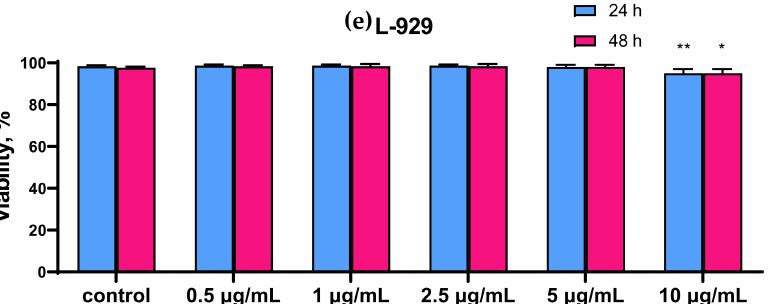
Figure 1. Comparison of the viability of intact cells and SeNP-treated cells for 24 and 48 h ( a )—A-172; ( b )—Caco-2; ( c )—Du-145; ( d )—MCF-7, ( e )—L-929. Data are expressed as percentage of control (intact cells; set to 100). Each value is the mean ± SD ( n ≥ 3, p < 0.05). Two-way ANOVA with Sidak’s multiple comparisons test. Comparison with control, *** p -level < 0.001, ** p -level < 0.01, * p -level < 0.05.